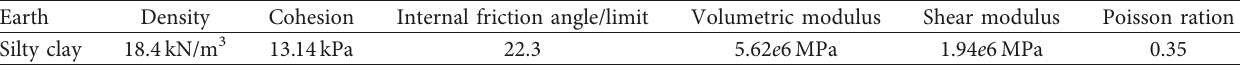
Table 1: Basic earth parameter.